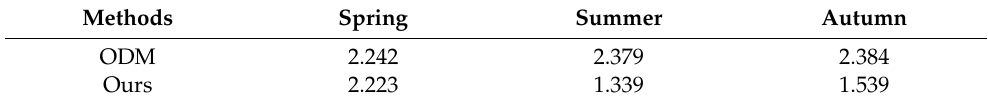
Table 3. SSIM values of two methods on color aerial image mosaic.